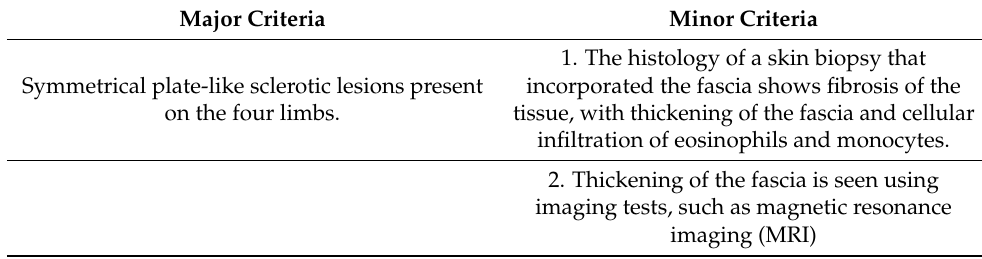
Table 1. Diagnostic criteria for EF. Major Criteria Minor Criteria 1. The histology of a skin biopsy that Symmetrical plate-like sclerotic lesions present incorporated the fascia shows fibrosis of the on the four limbs. tissue, with thickening of the fascia and cellular infiltration of eosinophils and monocytes. 2. Thickening of the fascia is seen using imaging tests, such as magnetic resonance imaging (MRI)